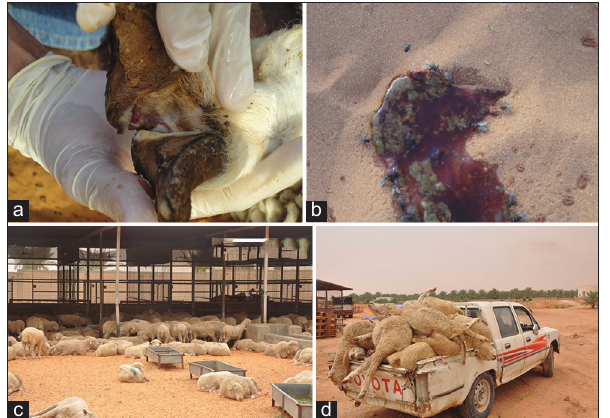
Figure-1: Different clinical signs of foot and mouth disease and peste des petits ruminants